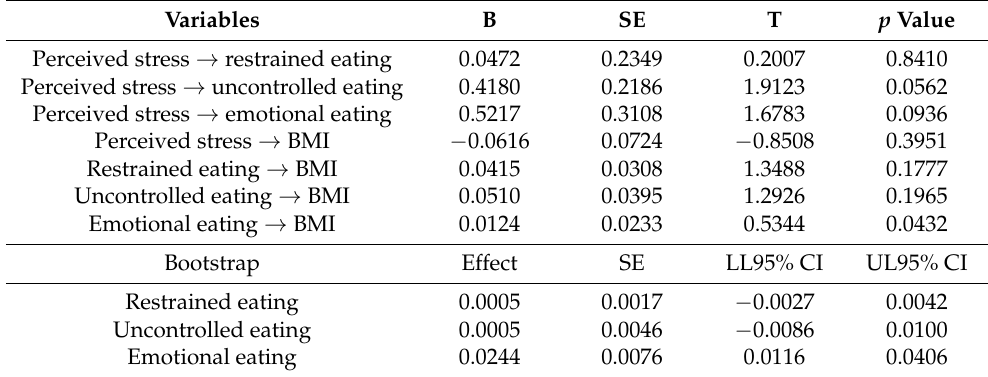
Table 9. Model A mediation analysis of eating behaviors on the relationship between perceived stress and BMI for females.